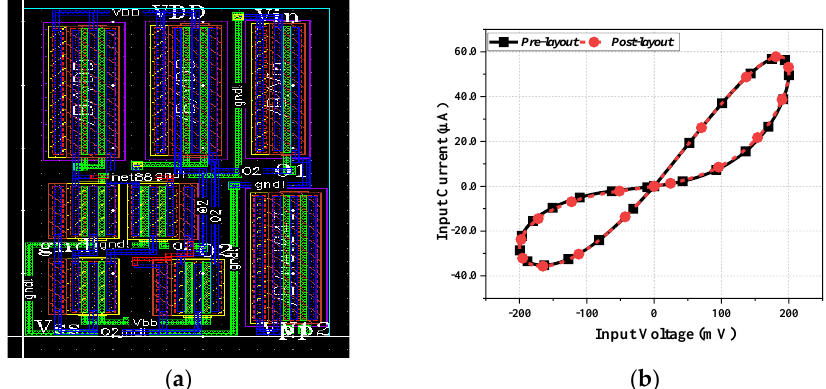
Figure 13. ( a ) Layout of proposed memristor design. ( b ) Pre-layout and post-layout PHL. Various connections of the proposed design are tested in Figure 14. Parallel connec- tions have less memristance value and conduct more current than single memristors.